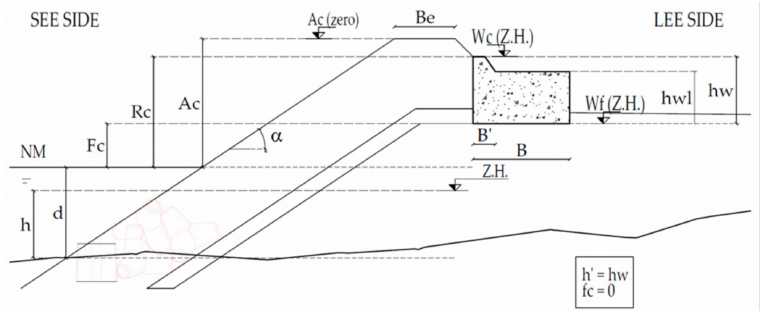
Figure 4. Geometrical parameters of the crown wall and main outer armor of a rubble mound breakwater with a monolithic crown